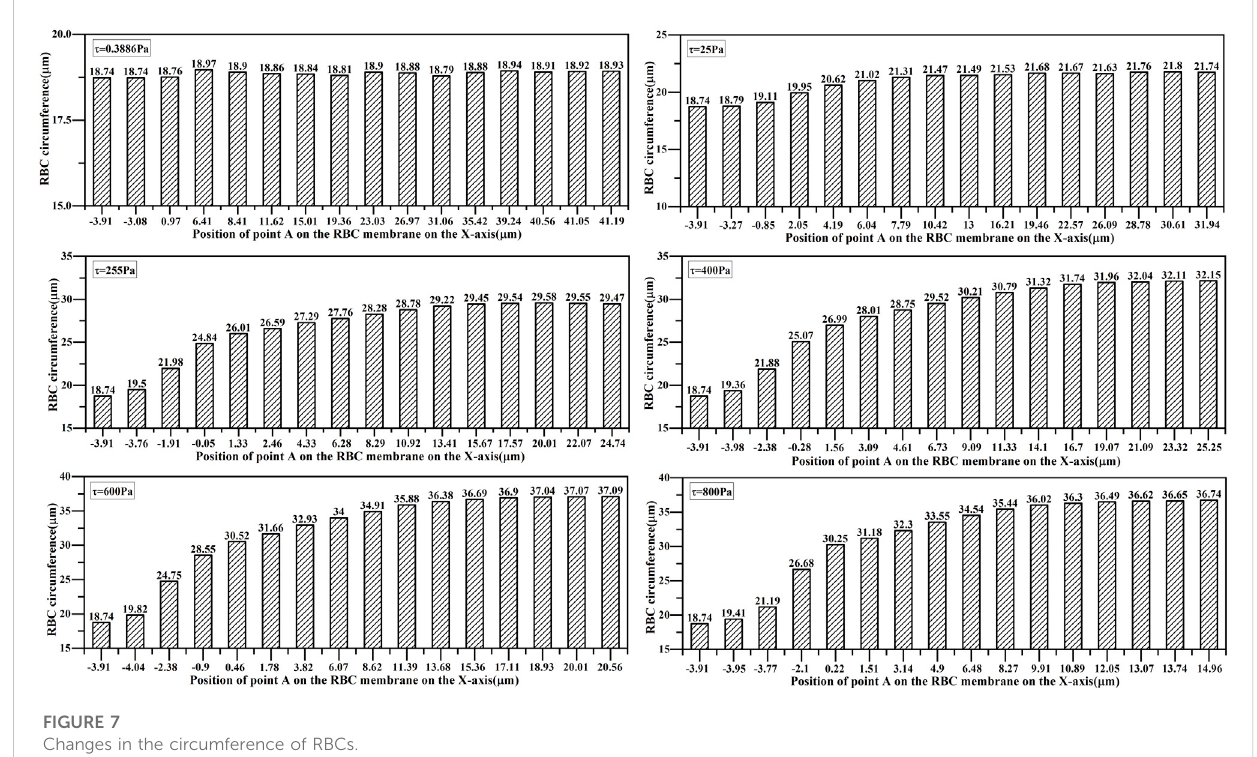
FIGURE 7 Changes in the circumference of